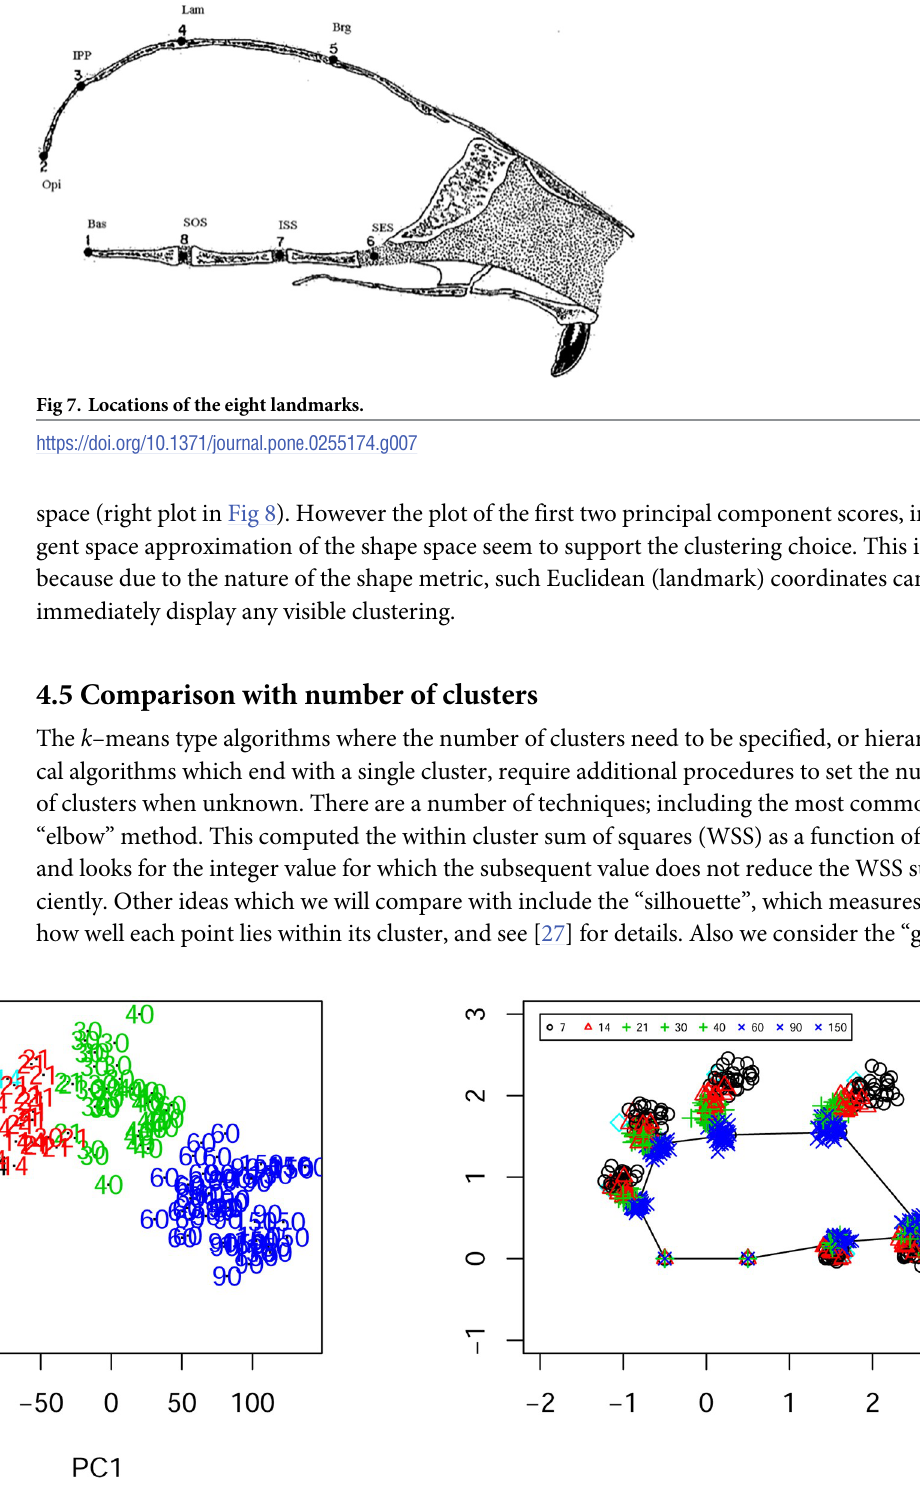
Fig 8. Clustering of the rats data. Left plot: the coordinates of the first two principal components in the tangent space; Right plot: Landmarks represented by symbols and colours based on the clusterings.